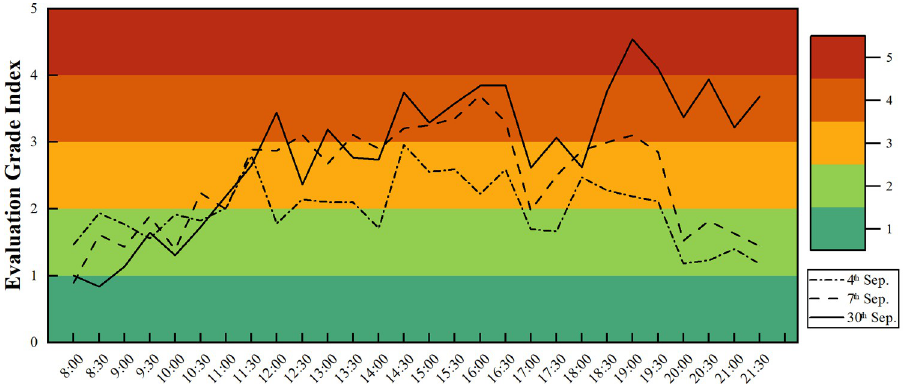
Fig 9. Evaluation grade index diagram of the passenger flow departure efficiency in the north square.